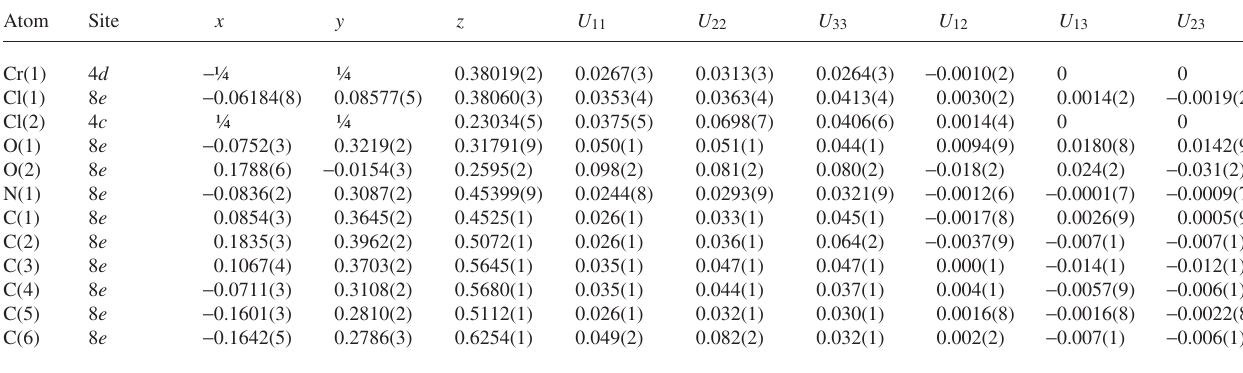
Table 3. Atomic coordinates and displacement parameters (in Å 2 ) .